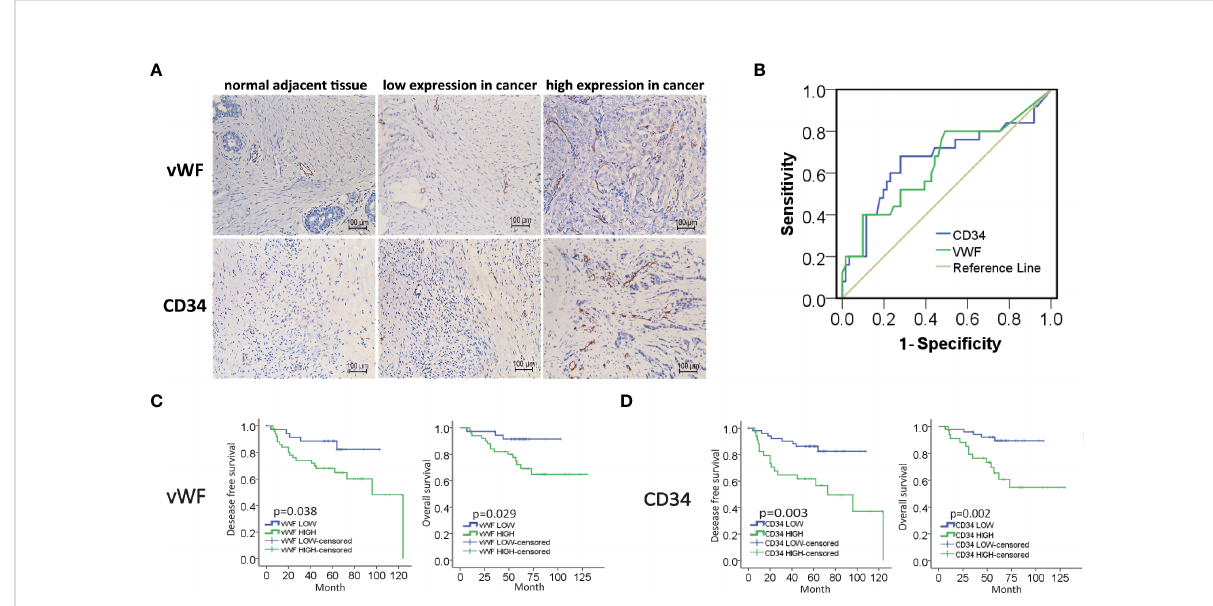
FIGURE 1 High expression of MVD predicted unfavorable prognosis of IDC patients. (A) Representative images of immunohistochemical (IHC) staining of vWF and CD34 in samples from breast invasive ductal carcinoma (IDC) patients. (B) ROC curve of the CD34 and vWF by the DFS of IDC patients. (C, D) Kaplan-Meier analysis of DFS and OS of IDC patients from our cohort by vWF and